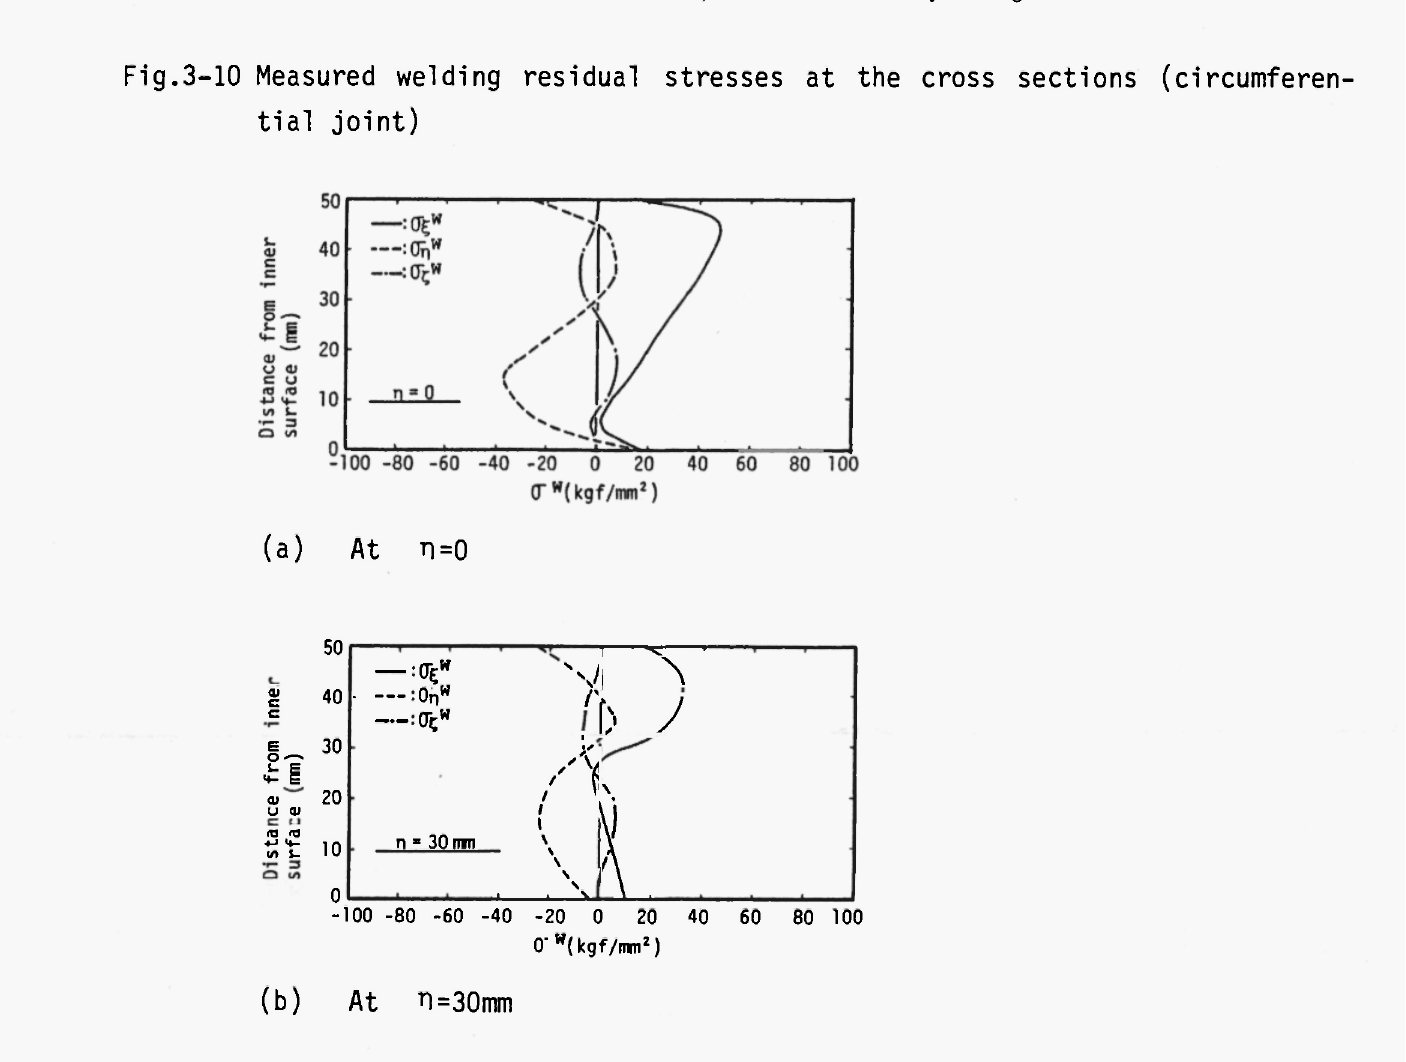
Fig.3-10 Measured welding residual stresses at the cross sections